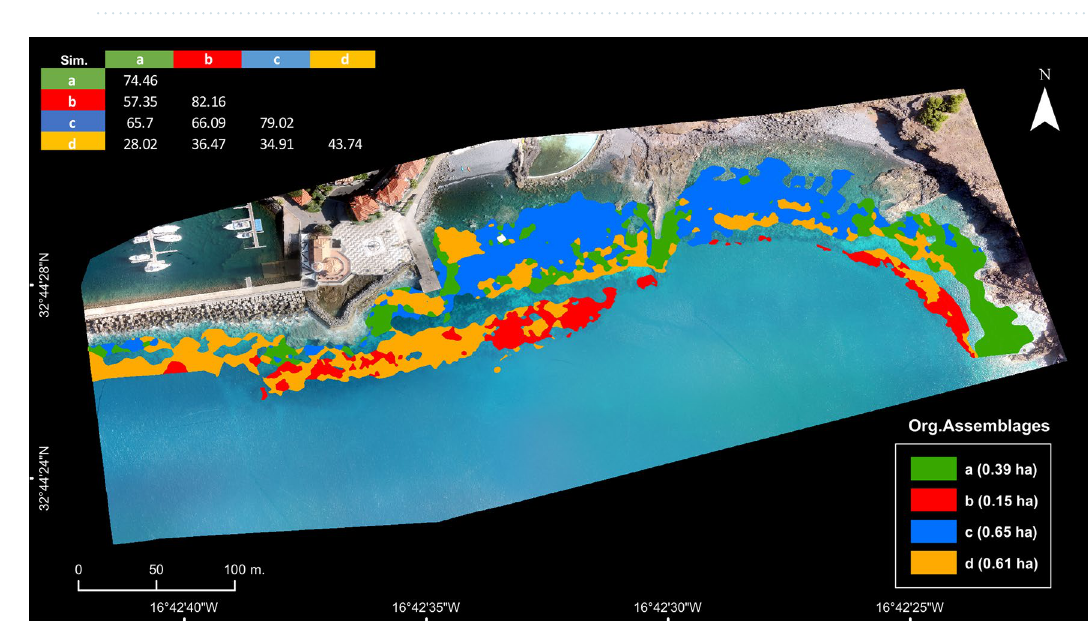
Figure 6. Extrapolated biotope ( a – d ) distribution (coloured map) and estimated area of unique organism assemblages (lower right corner) over distinct rocky substrate categories within the surveyed depth classes (biotope similarity matrix between biotopes on top-left corner). Map and figure generated in ESRI ArcGIS Desktop